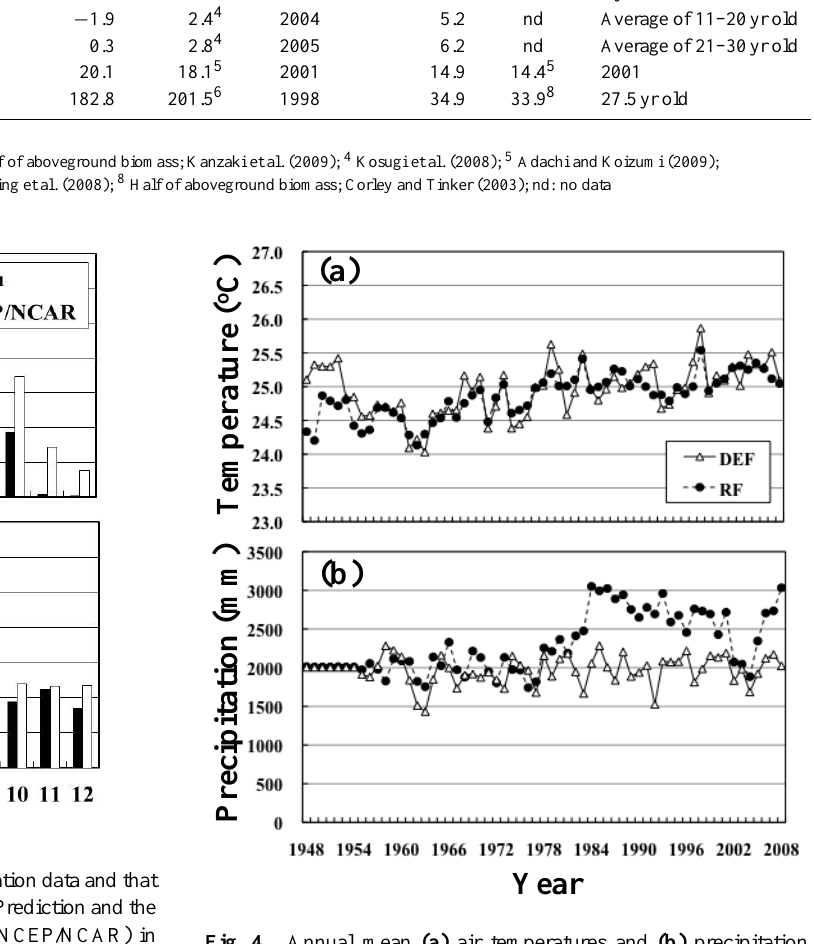
Fig. 4. Annual mean (a) air temperatures and (b) precipitation in dry evergreen forest (DEF) in Thailand and rainforest (RF) in Malaysia based on NCEP/NCAR data from 1948 to 2008. Precip- itation data were corrected using the observed monthly mean pre- cipitation (Fig.